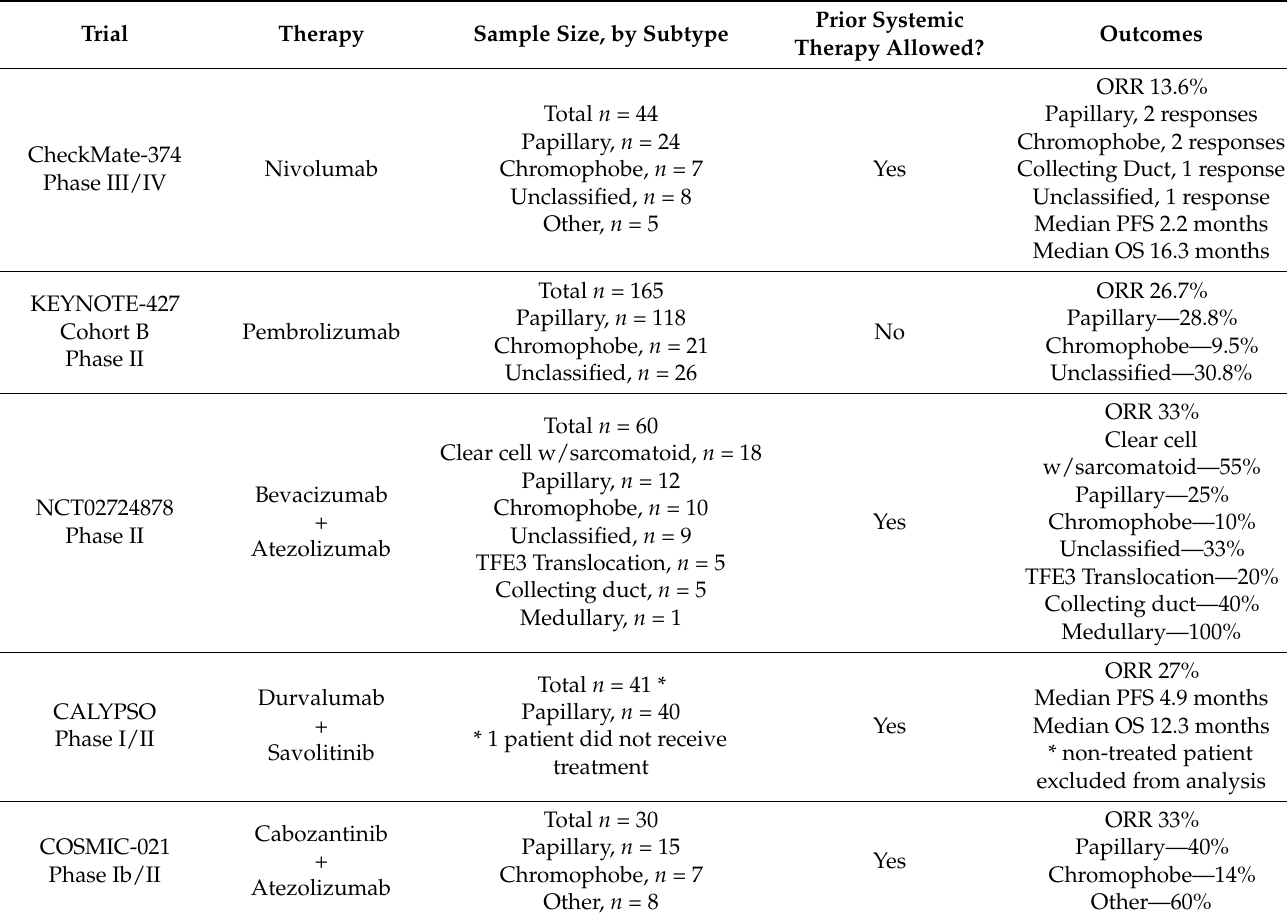
Table 1. Completed prospective single-arm studies of immunotherapy in